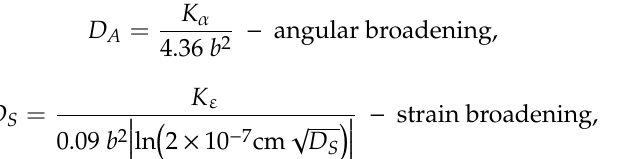
Table 2. Etchants used for revealing etch pits in (100) GaSb epilayer. RT ( room temperature)